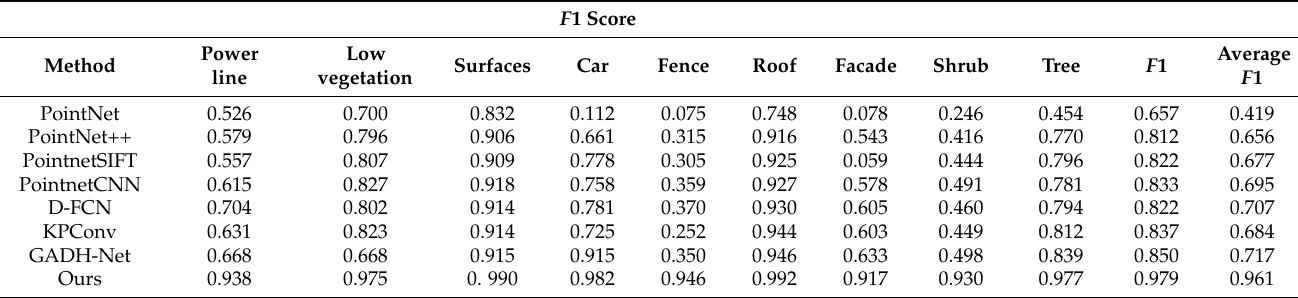
Table 3. Comparison of the proposed algorithm and deep learning algorithm.